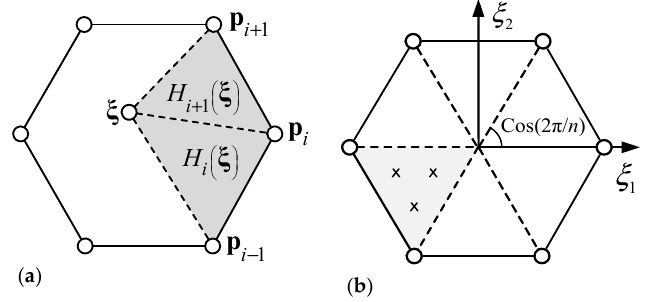
Figure 1. Polygon element definition: ( a ) define α